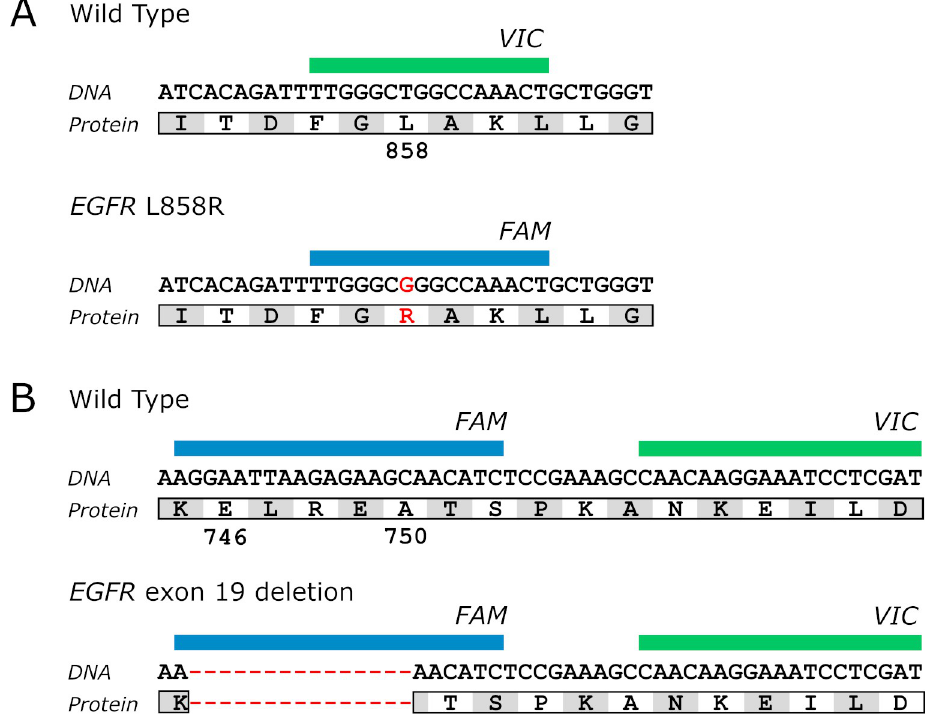
Fig 1. Droplet digital PCR probe design to detect EGFR L858R substitution (A) and EGFR exon 19 deletion